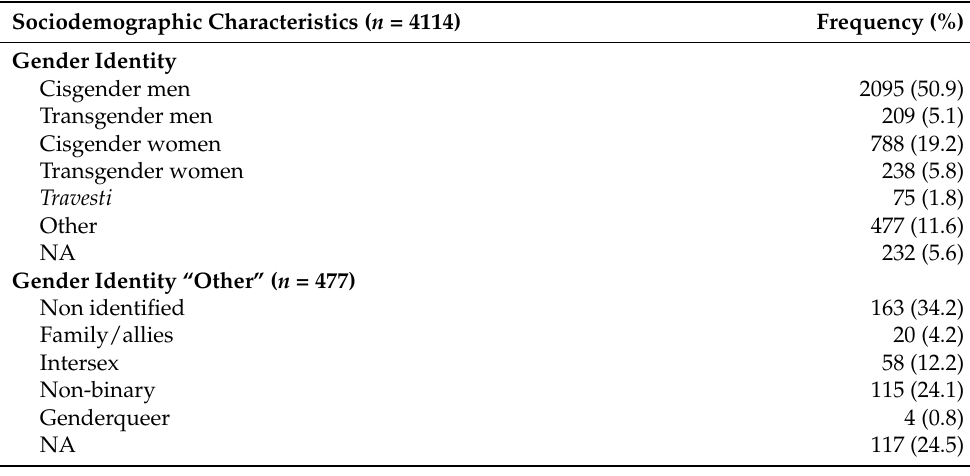
Table 2. Sociodemographic characteristics of the Dandarah App users, Brazil, 2019–2022 *. Sociodemographic Characteristics ( n =